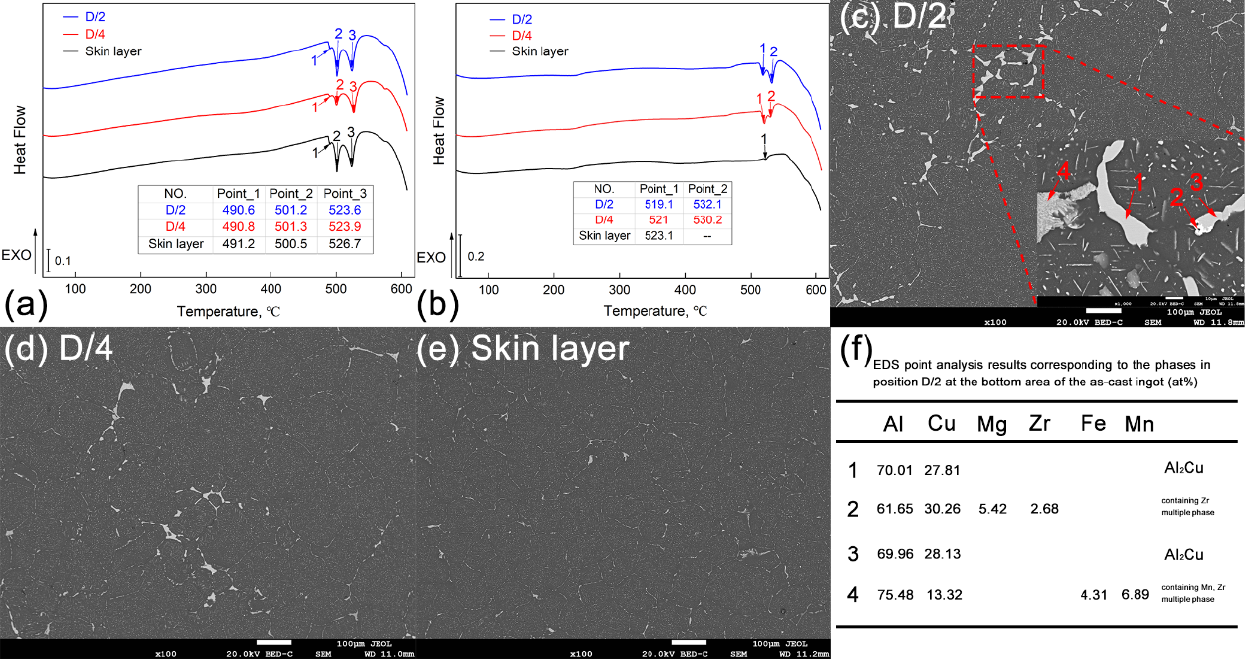
Figure 4. DSC analysis results of the as ‐ cast Al ‐ Cu ‐ Mg ‐ Ag alloy ( a ) and the homogenized Al ‐ Cu ‐ Mg ‐ Ag alloy ( b ), SEM ‐ BSE images and the EDS point analysis results of the homogenized Al ‐ Cu ‐ Mg ‐ Ag alloy ( c ), ( d ), ( e ), and ( f ).